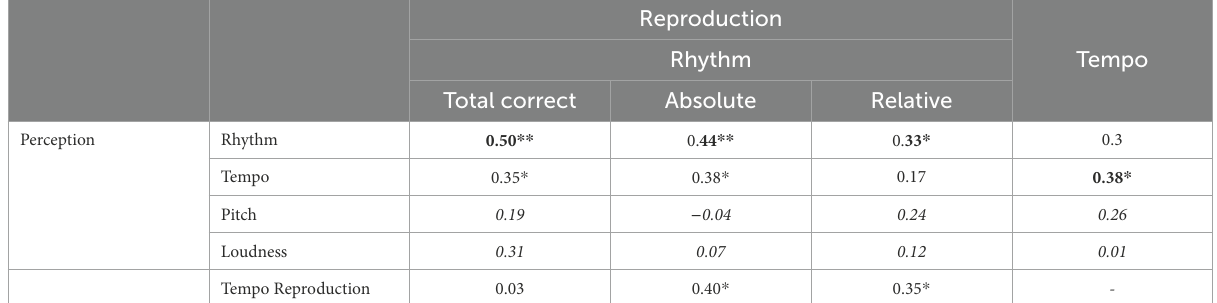
TABLE 5 Correlation between PROMS perception subtests (left column) and rhythm and tempo reproduction tasks (upper row). The correlations between accuracy of tempo reproduction and the three measures of rhythm reproduction ability are reproduced in the bottom